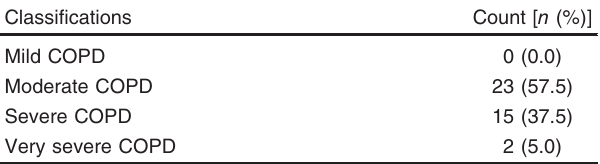
Table 2 Classification of chronic obstructive pulmonary disease patients according to severity using FEV1